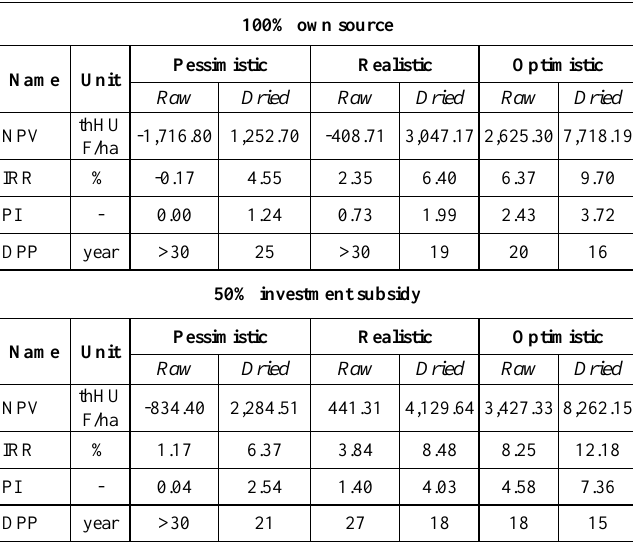
Table 14. Results of scenario analysis with 100% own source and 50% investment